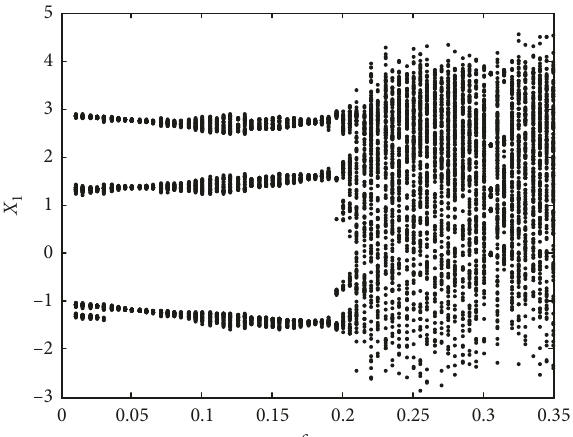
Figure 3: The displacement bifurcation graph of velocity pulsation amplitude ( Ω � 2, ω � 1, c � 0.05, r � 0.5, p � 10, c � 0.5, and the initial value is [0.05, 0, 0.05, 0]).